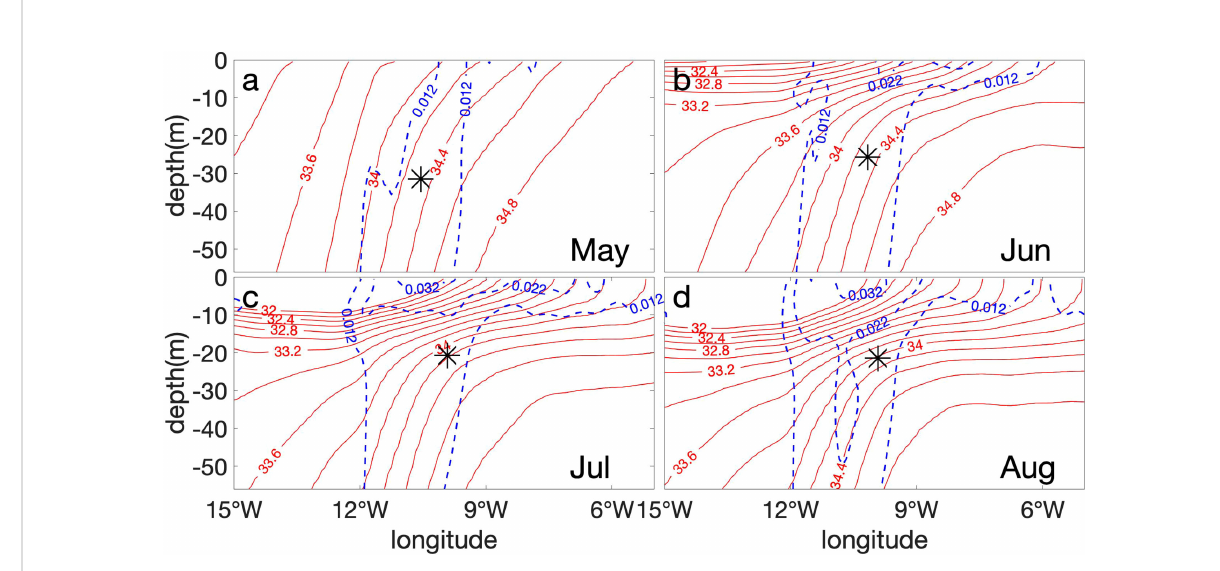
FIGURE 7 Climatological monthly salinity and salinity gradient along the red line section in Figure 1A ( A – D for May to August). The red solid lines are the salinity isolines, the blue dashed lines are the salinity gradient isolines, and the black marks represent the centers of the salinity front in the upper 55-m section.